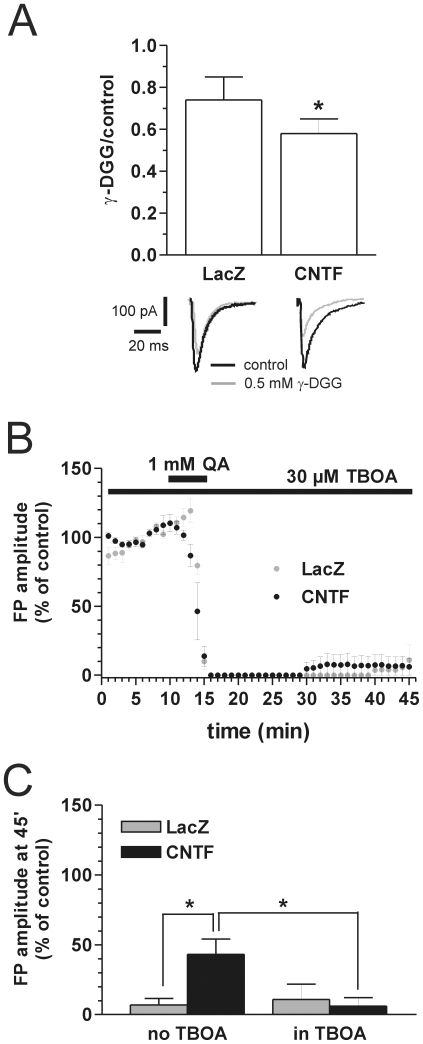
The neuroprotective effect of CNTF is mediated by GTs.
A: γ-DGG has a significantly higher inhibitory effect in CNTF slices compared to LacZ: the histogram represents the ratio between EPSC amplitude in the presence of 0.5 mM γ-DGG and in control conditions (*p<0.05, Mann-Whitney test). Traces show representative EPSCs (HP = -60 mV). B: in the presence of the GTs inhibitor TBOA, there is little and similar FP recovery from QA excitotoxicity in both groups. C: summary of FP amplitude data at t = 45 min in the absence and in the presence of 30 µM TBOA (*p<0.05, Mann-Whitney test).